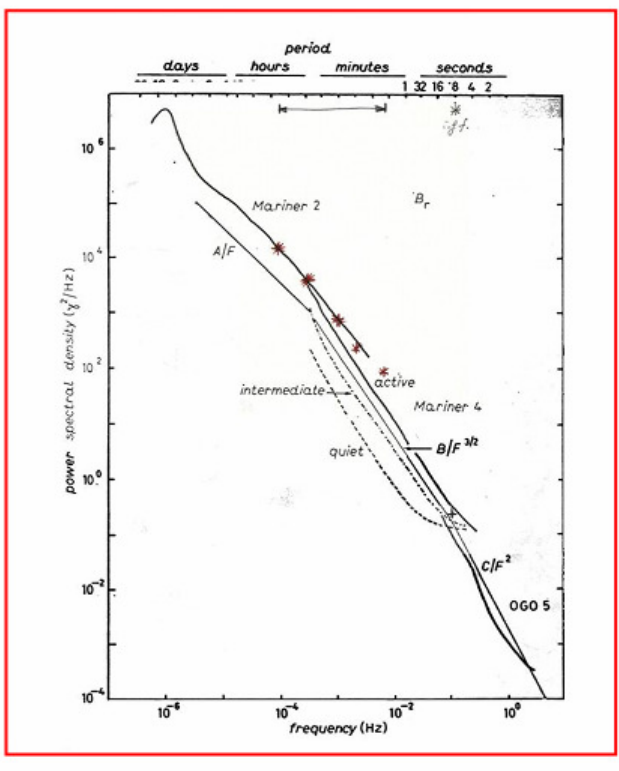
Figure 21: A composite figure of the magnetic spectrum obtained by Russell